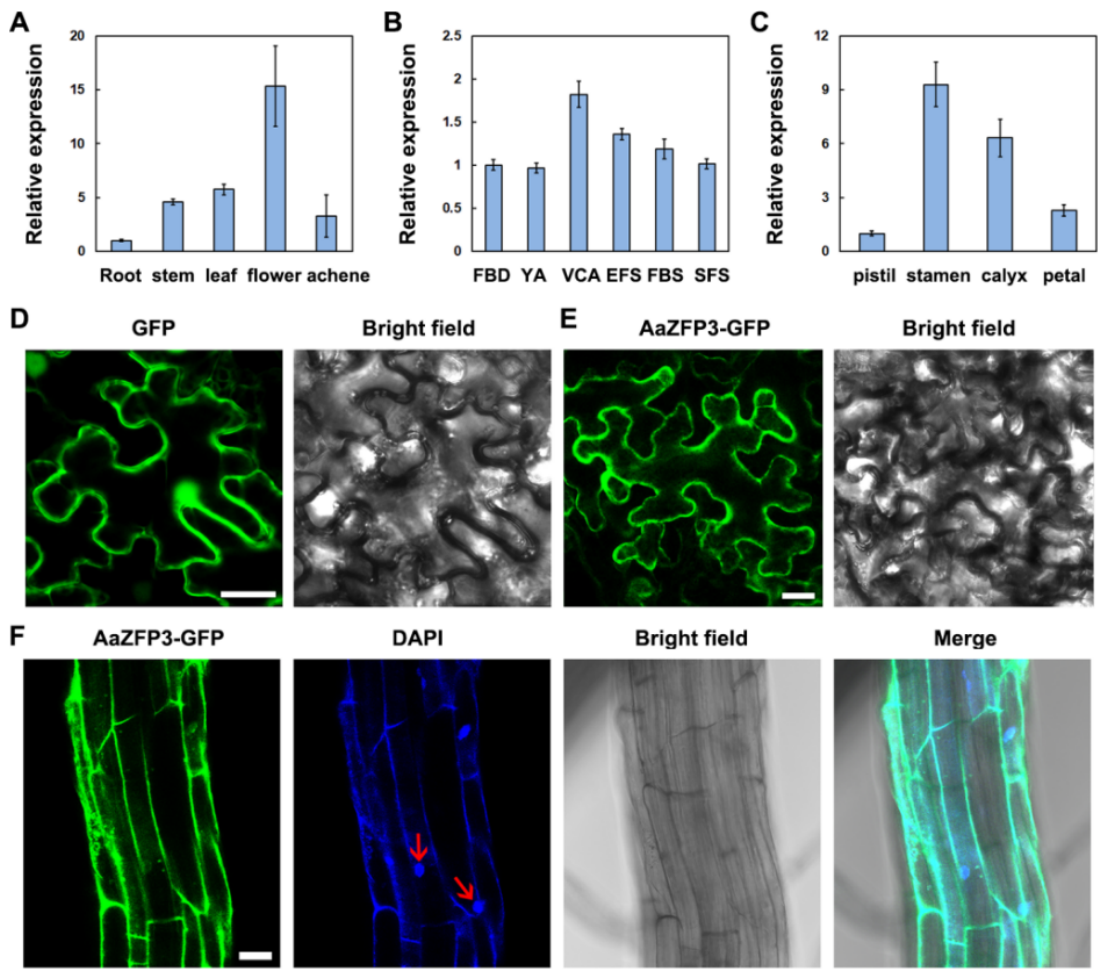
Figure 2. Tissue expression specificity and subcellular localization of AaZFP3 . ( A – C ) Relative expression levels of the AaZFP3 gene in ( A ) various organs, ( B ) floral organs at different developmental stages, and ( C ) different flower tissues in Adonis amurensis. FBD, flower bud differentiation; YA, young alabastrum; VCA, visible color alabastrum; EFS, early flowering stage; FBS, full bloom stage; SFS, senescing flower stage. The AaActin gene provided the internal control, and the transcript level in the root or floral organs at flower bud differentiation or pistil was consistently 1.0, respectively. ( D – E ) Confocal images of tobacco leaf cells transiently expressing ( D ) GFP (control) or ( E ) AaZFP3-GFP. ( F ) Confocal images of transgenic Arabidopsis stem cells stably expressing AaZFP3-GFP (green) with DAPI (blue) staining. Red arrows indicate nuclei stained with DAPI. Scale bars = 20 μ m.